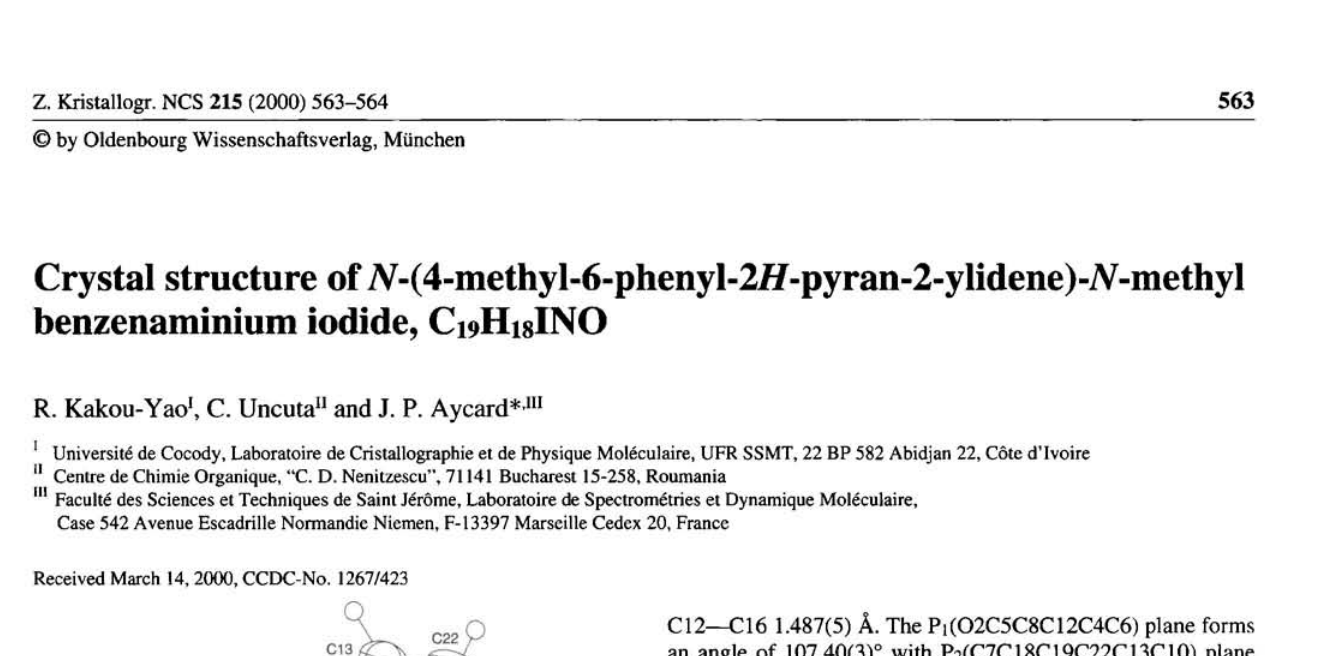
Table 1. Data collection and handling.